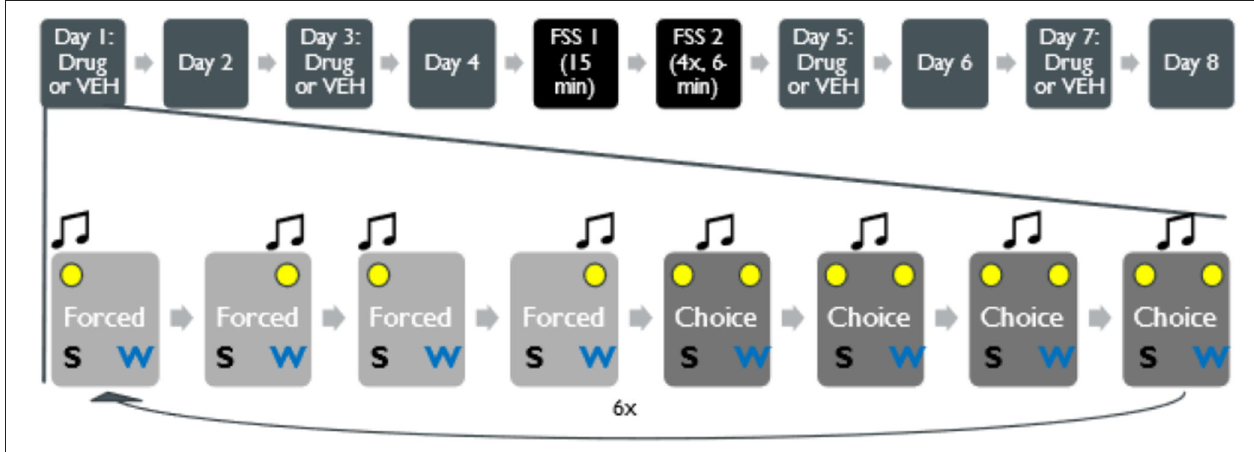
FIGURE 1 | Structure of concurrent-choice operant conditioning task in a within-subjects design. Top, following conditioning, mice underwent 8 days of decision-making task: stress naïve behavior was recorded for 4 days before rFSS (or no stress) and 4 days after the stress. On days 1, 3, 5, and 7, in a counterbalanced fashion, animals designated to receive drug microinjection were injected with drug into the NAc via bilateral cannula implantation 15min before the start of the task. The rFSS was conducted over 2 days. The first day, animals swam for 15min, and the second day, animals swam 4 times for 6min each time. Animals in a no stress condition could rest for 2 days. Bottom, within a single session, there were 48 trials, half of which were forced choice trials organized in a pseudorandom order. Following 4 trials of forced-choice for either water or sucrose with audio (8 or 15kHz) and visual cues (cue light directly above the associated receptacle), 4 free-choice sessions were available (4-kHz noise and both cue lights on). This was repeated 6 times throughout the session for a total of 48